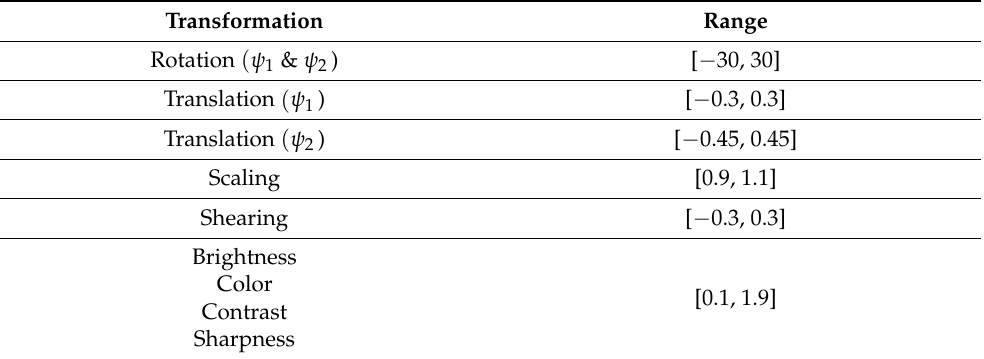
), and ( c ) examples of im- (cid:2870)